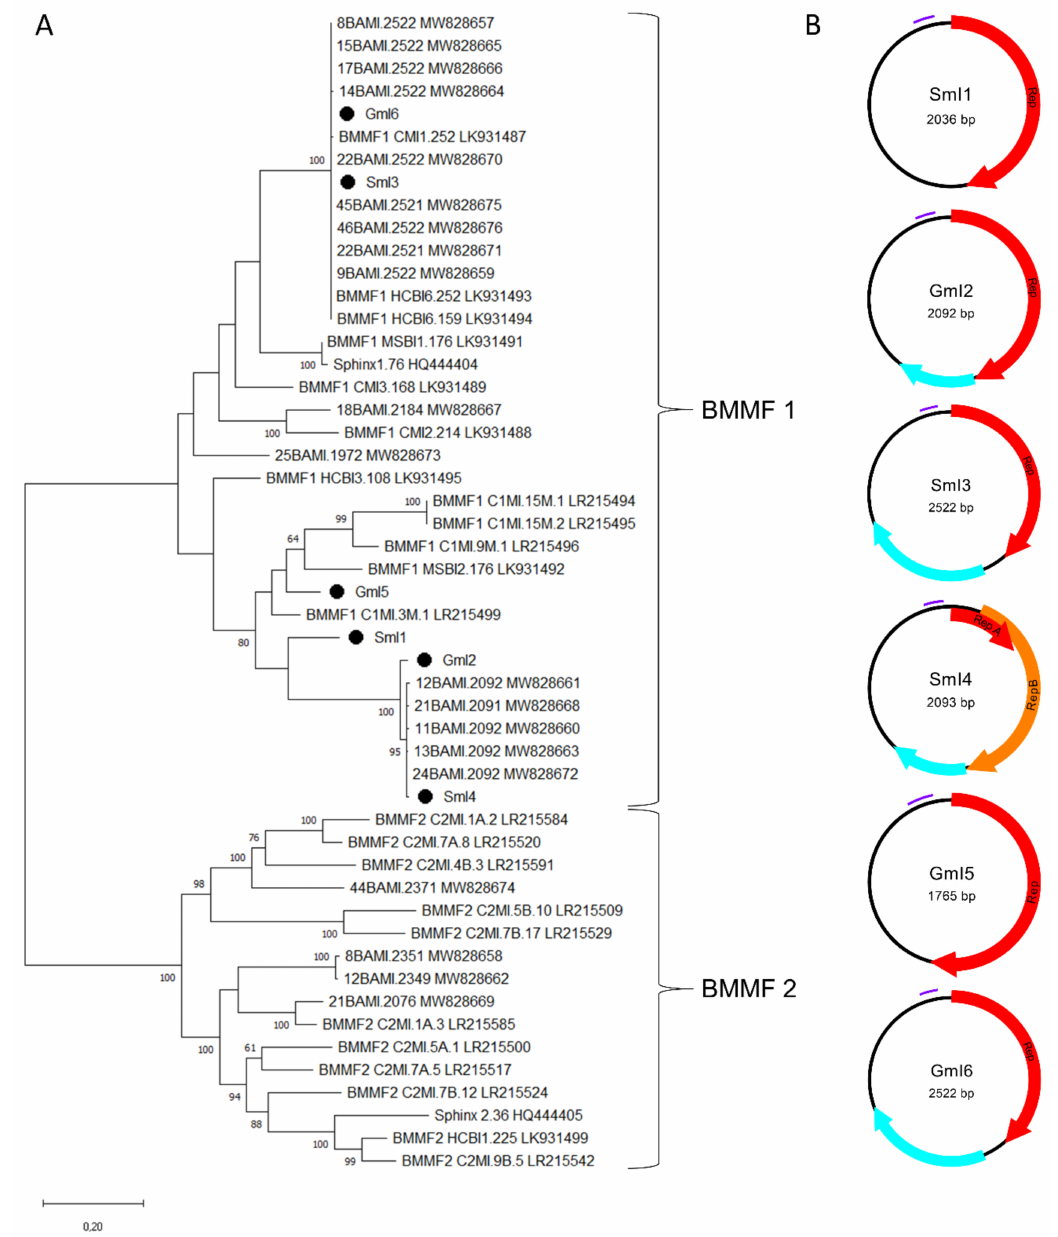
Figure 4. ( A ) Maximum Likelihood phylogenetic tree of novel full-length Sphinx-like DNA genomes, Sphinx 1.76, Sphinx 2.36, selected members of BMMF group 1 and 2 and recently published Sphinx-like DNA genomes isolated from water buffalo milk. The evolutionary history was inferred by using the Maximum Likelihood method and Tamura-Nei model [37]. The tree with the highest log likelihood (“-“50216.13) is shown. The percentage of trees in which the associated taxa clustered together is shown next to the branches [38]. Branch support values lower than 60% were not included. The tree is drawn to scale, with branch lengths measured in the number of substitutions per site. This analysis involved 51 nucleotide sequences. There were a total of 4500 positions in the final dataset. Black dots mark sequences found in this study. All taxa are indicated by name followed by the corresponding GenBank accession number. ( B ) Genomic organization of the six new BMMF-like genomes from this study. Red and orange arrows indicate rep -genes, blue arrows show further potential ORFs and purple bars represent tandem repeat